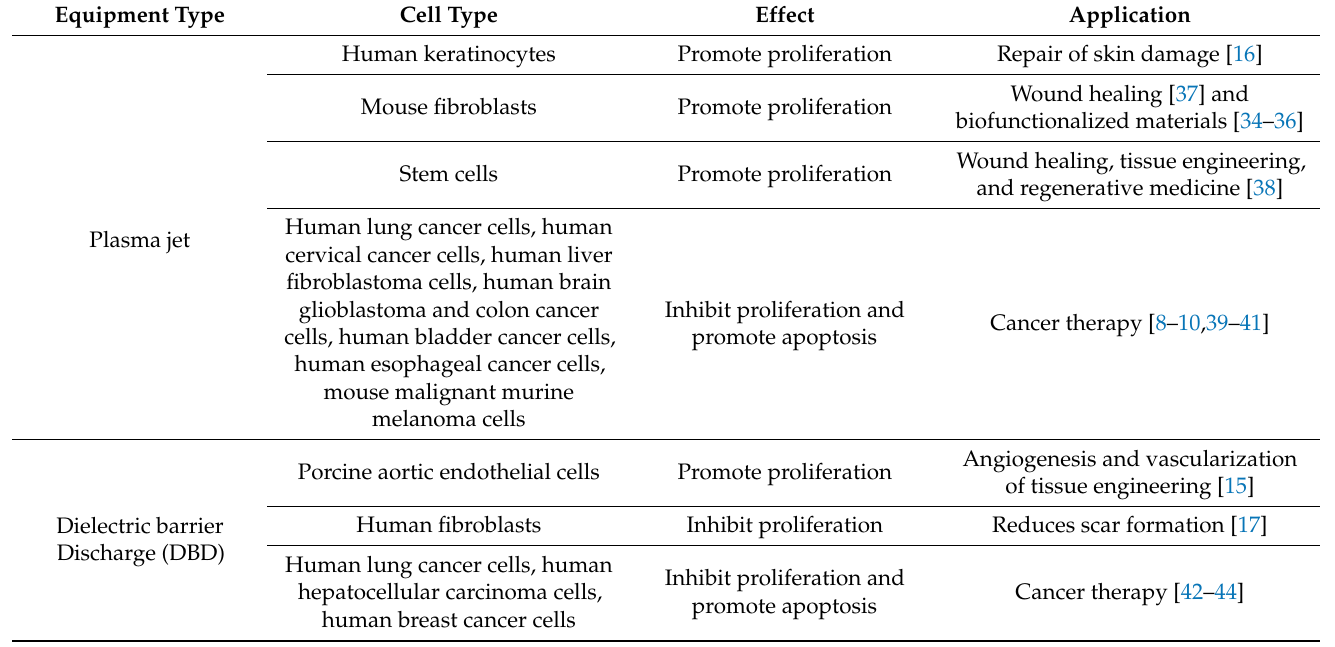
Table 1. Applications of cold plasma treatment in regulating cell